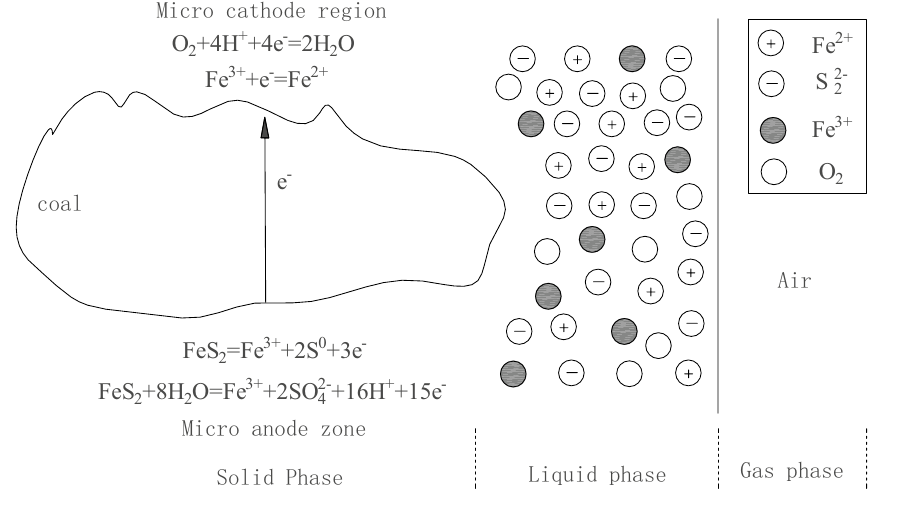
Figure 6. Electrochemical oxidation of pyrite in